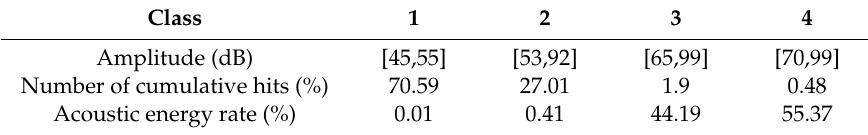
Figure 13. ( a ) Representation of events in amplitude/deformation, ( b ) cumulative acoustic energy of the different classes for the 90° specimen types. Table 5. Distribution of the parameters of the damage classes for the 90° specimens.